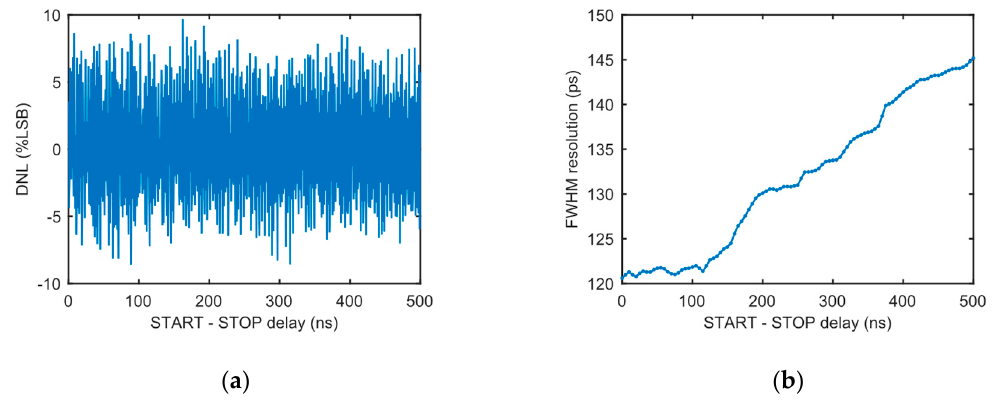
Figure 7. Measured ( a ) differential nonlinearity (DNL) and ( b ) full width at half maximum (FWHM) timing resolution of the time-to-digital conversion module in the proposed TCSPC system.